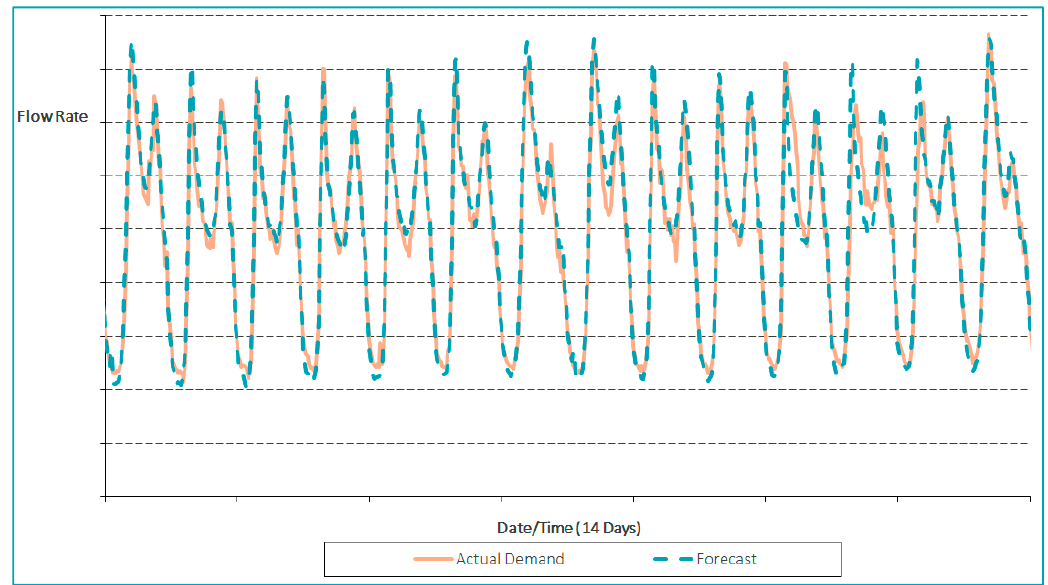
Figure 4. Demand Forecasting Model